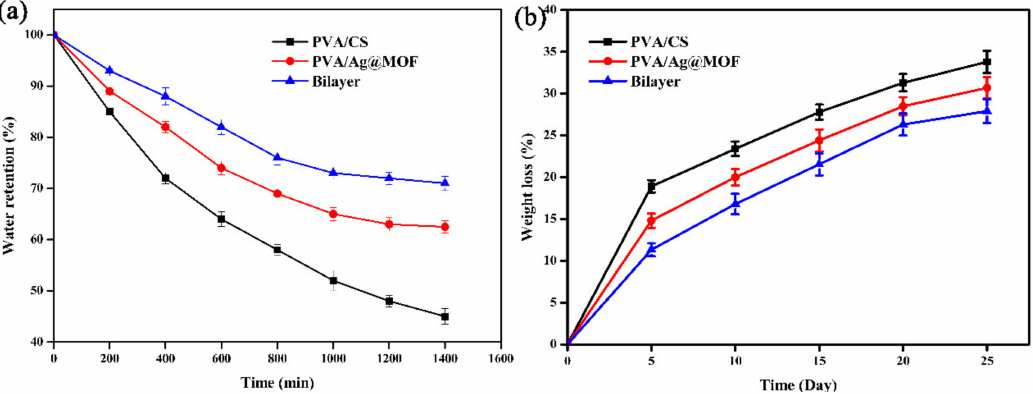
Figure 5. ( a ) Water retention and ( b ) degradation of PVA/CS (outer hydrogel), PVA/Ag@MOF (inner hydrogel), and Bilayer